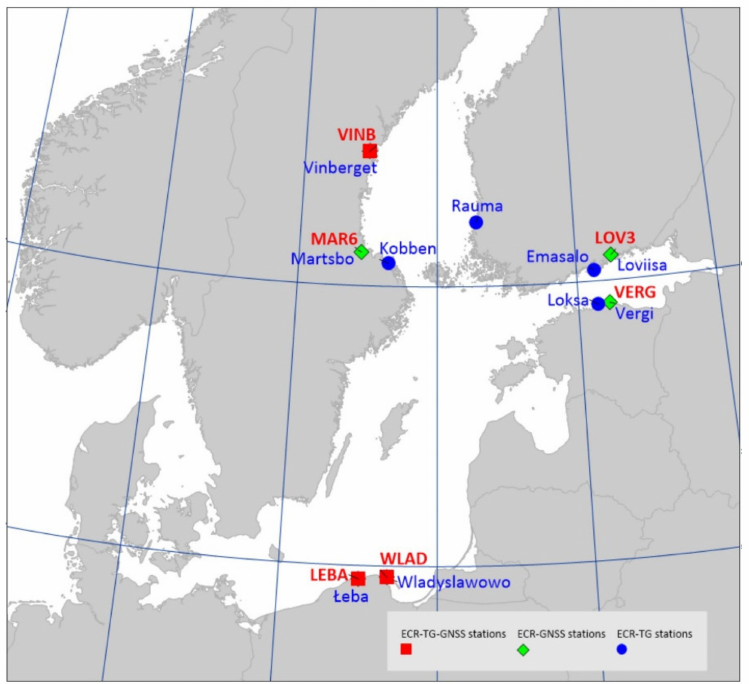
Figure 1. Baltic Sea test network showing ECR locations and ties to GNSS and/or tide gauge stations. Exact coordinates are shown in Table